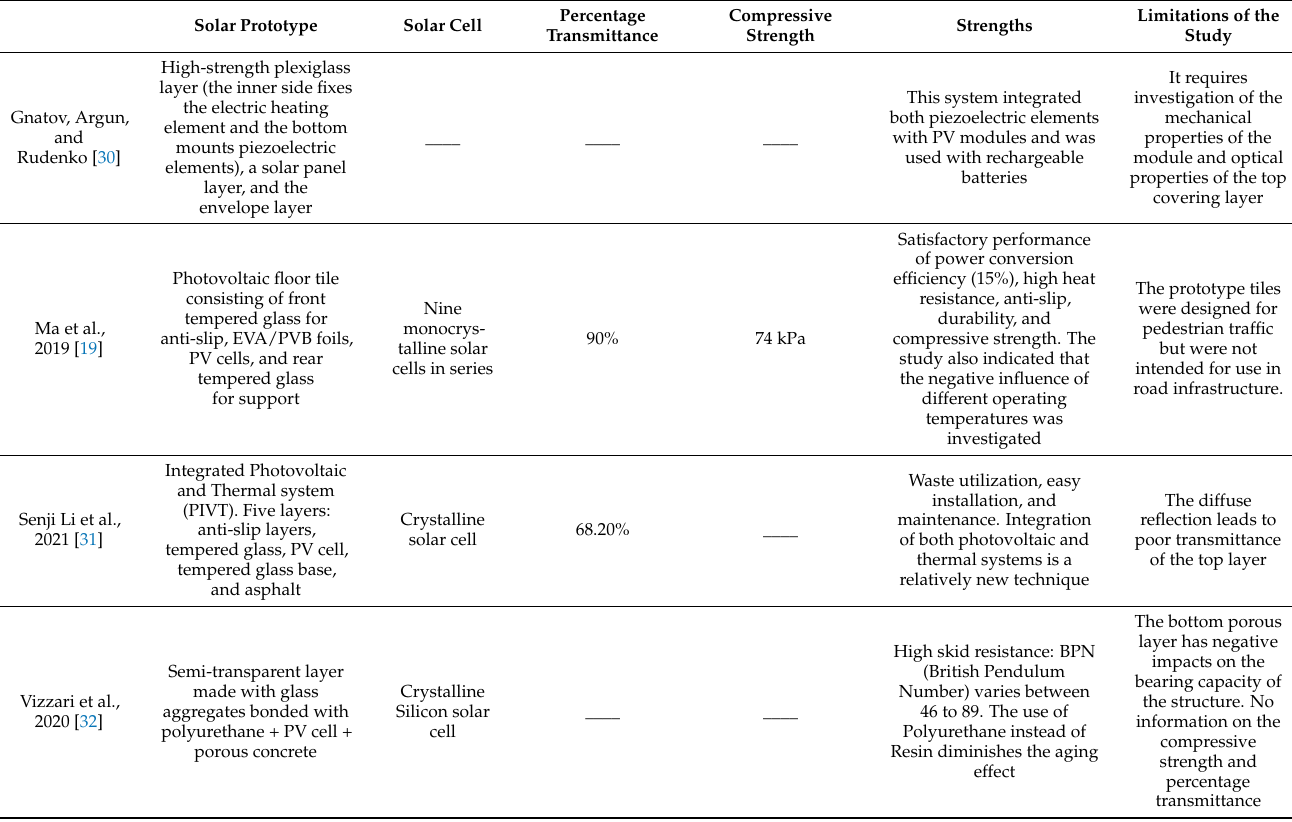
Table 1. Recent studies on layered PV solar panel